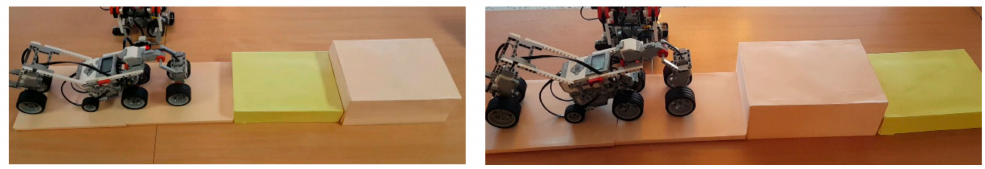
Figure 9. The case study evaluation: the manipulating robot overcomes two obstacles.